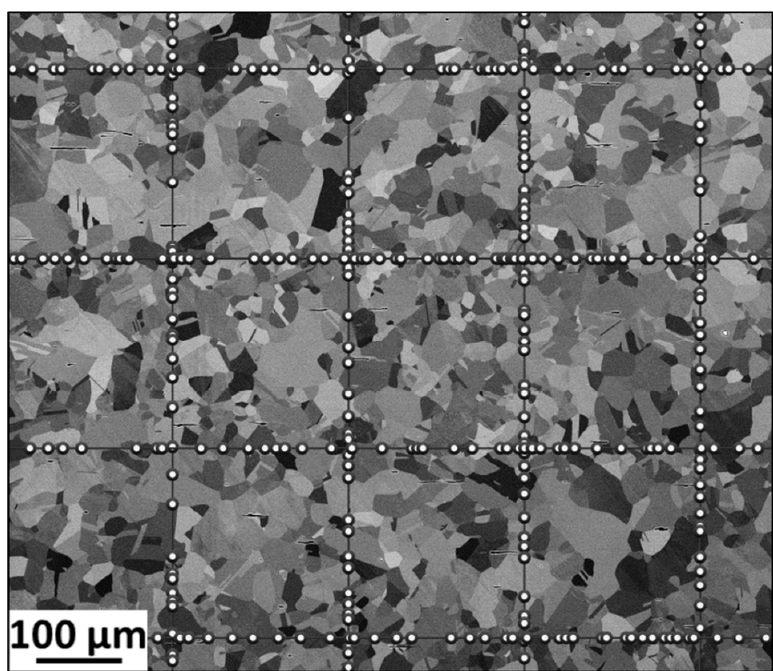
Figure 2. Representative backscatter electron (BSE) micrograph of a recrystallized microstructure ( d = 19 μ m, c = 16 μ m) with four horizontal and four vertical lines used for grain size analysis using the Heyn lineal intercept procedure.